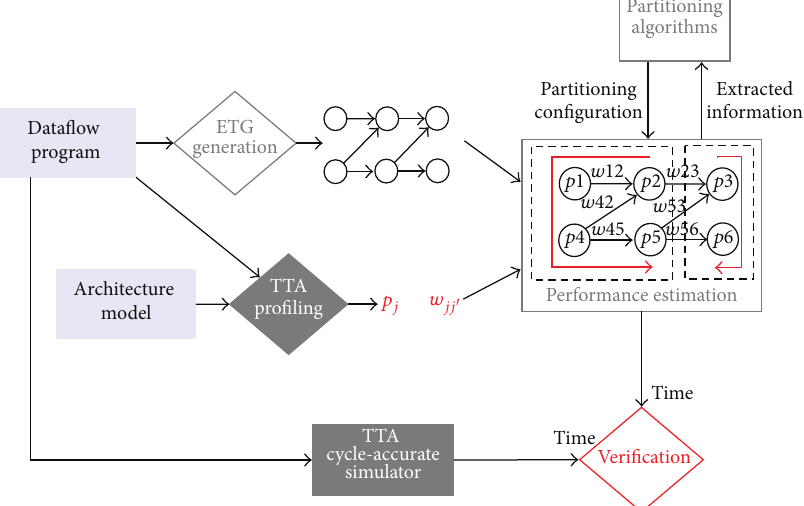
Figure 4: Experimental workflow.